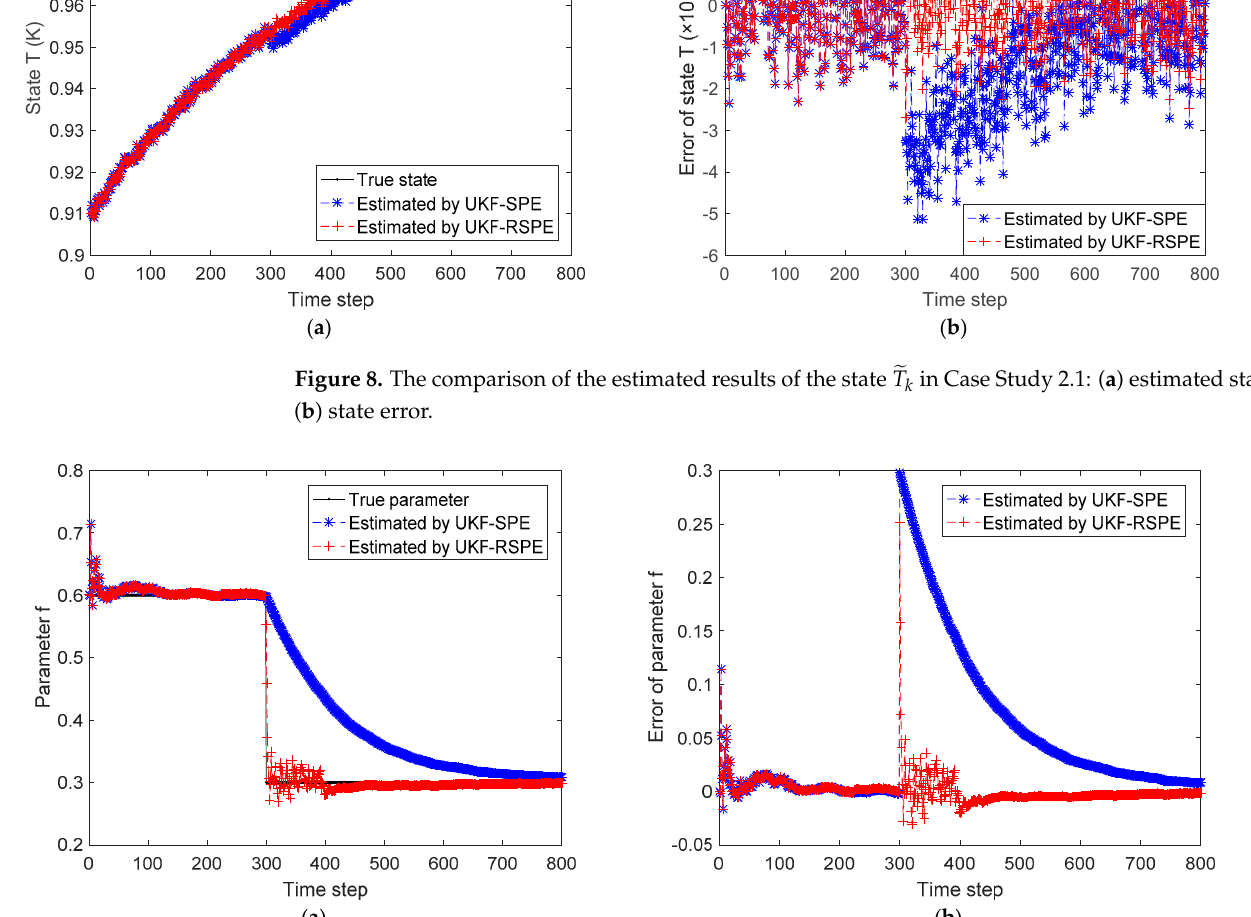
Figure 9. The comparison of the estimated results of parameter f in Case Study 2.1: ( a ) estimated parameter; ( b ) parameter error.